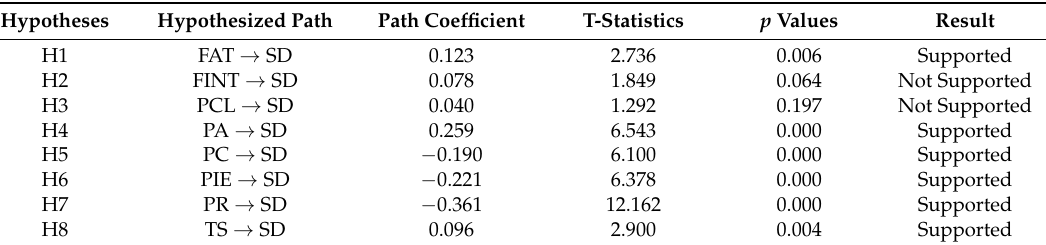
Table 5. Path coefficients and their significance.